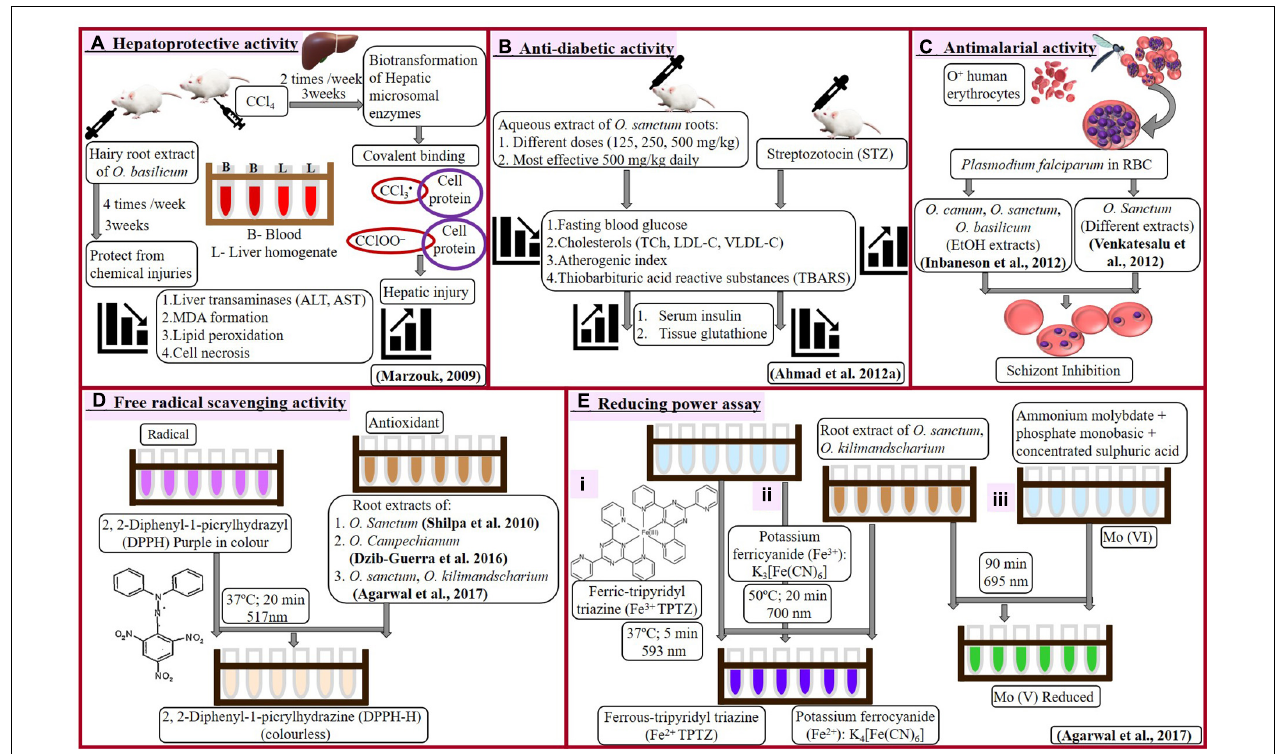
FIGURE 2 | Hepatoprotective (A) , antidiabetic (B) , antimalarial (C) , and antioxidant ( D -free radical scavenging and E -reducing power assay) activities of Ocimum sp.